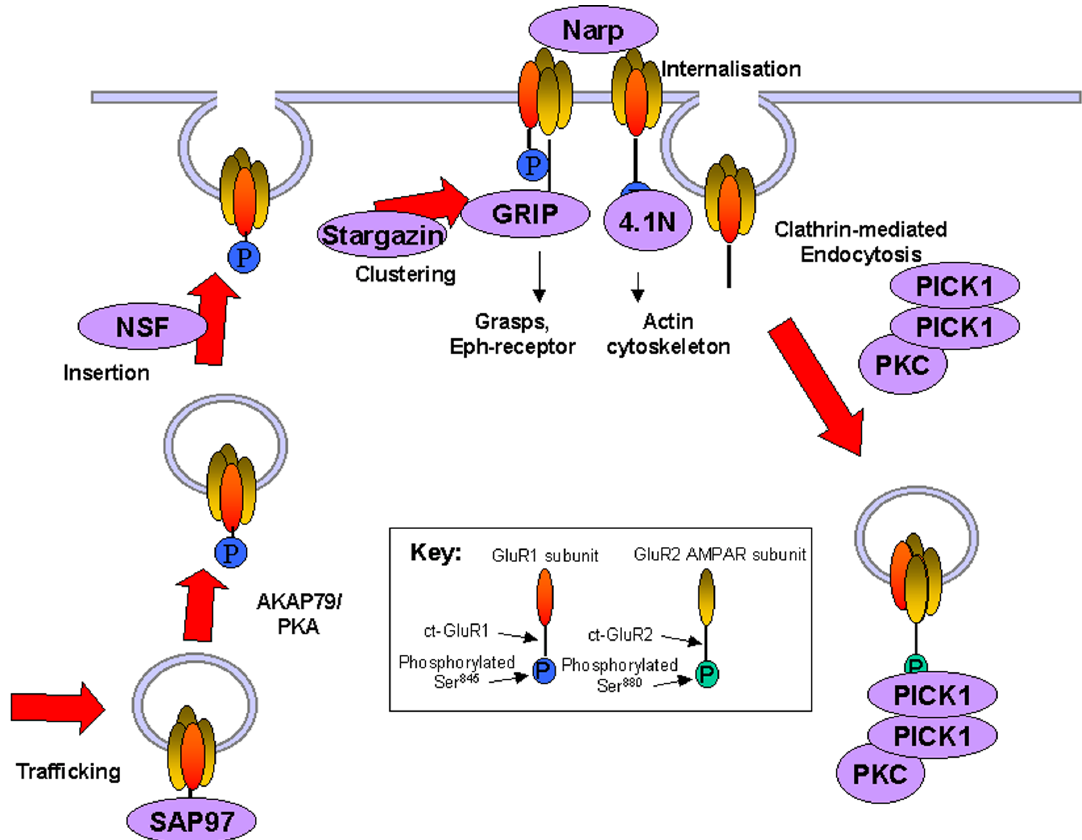
FIGURE 3. Simplified model showing the possible roles of individual AMPAR interacting